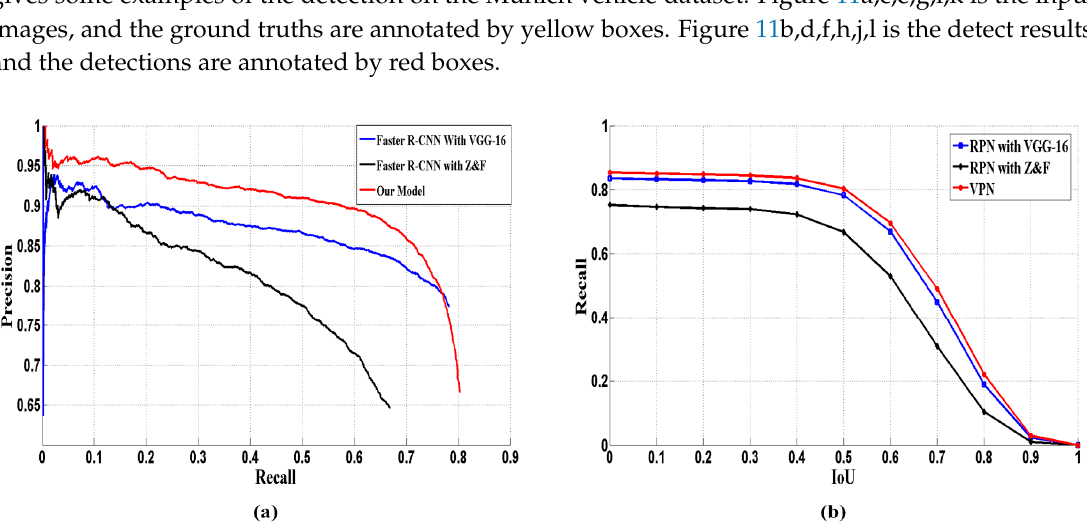
Figure 11. ( a – l ) some detection examples of VEDAI dataset. 5. Conclusions In this paper, we propose a fast and accurate vehicle detection model for aerial images. Unlike the traditional sliding-window-based detection models and recent CNN-based models, our detector is a cascaded CNNs architecture that combines two CNNs (VPN and VDN) for generating